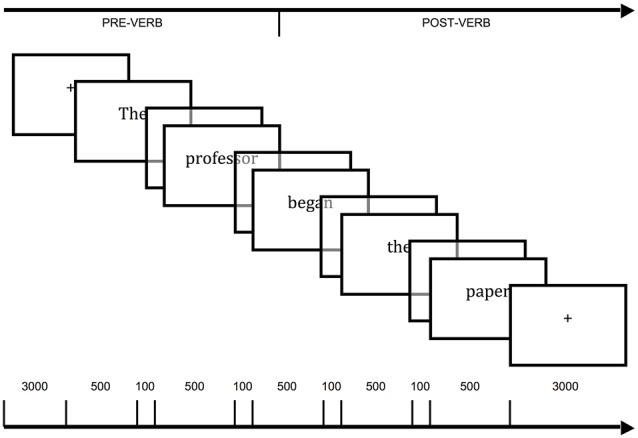
Time course of stimuli presentation employed in the functional magnetic resonance imaging (fMRI) experiment. Each word was presented for 500 ms with an interstimulus interval (ISI; blank screen) of 100 ms. The total intertrial interval (fixation point, “+”) was 6000 ms. The main data analyses took into account blood oxygenation level dependent (BOLD) signal change from “pre-verb” event (3000 ms of fixation point plus The professor) to “post-verb” event (which included the verb and complement, began the paper, plus 3000 ms of fixation point).